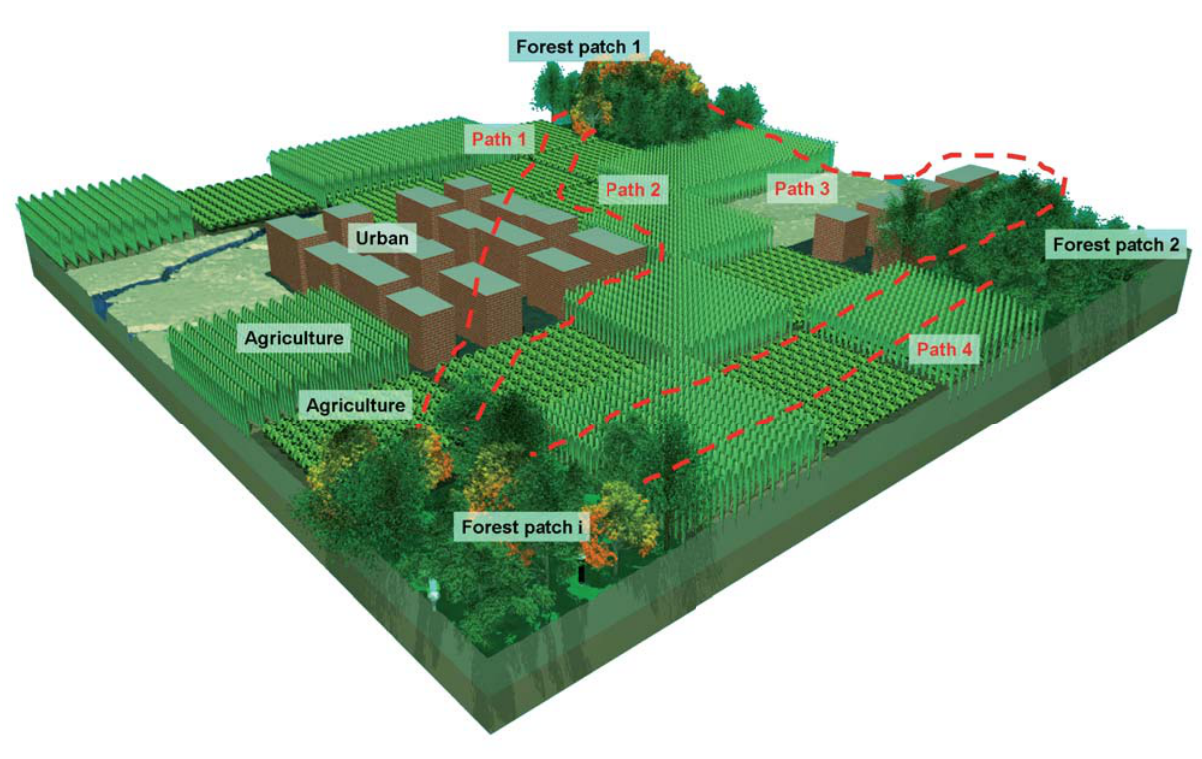
Figure 1. A hypothetical landscape with examples of Euclidean distances (Paths 1 and 4) and Effective distances (Paths 2 and 3) between habitat for generalist species (Forest patches i, 1, & 2) and specialist species (Patches i & 1). Larval host trees for a specialist species are indicated with non-green foliage. Two of the four beetle traps within sampling arrays are shown in the surveyed patch,